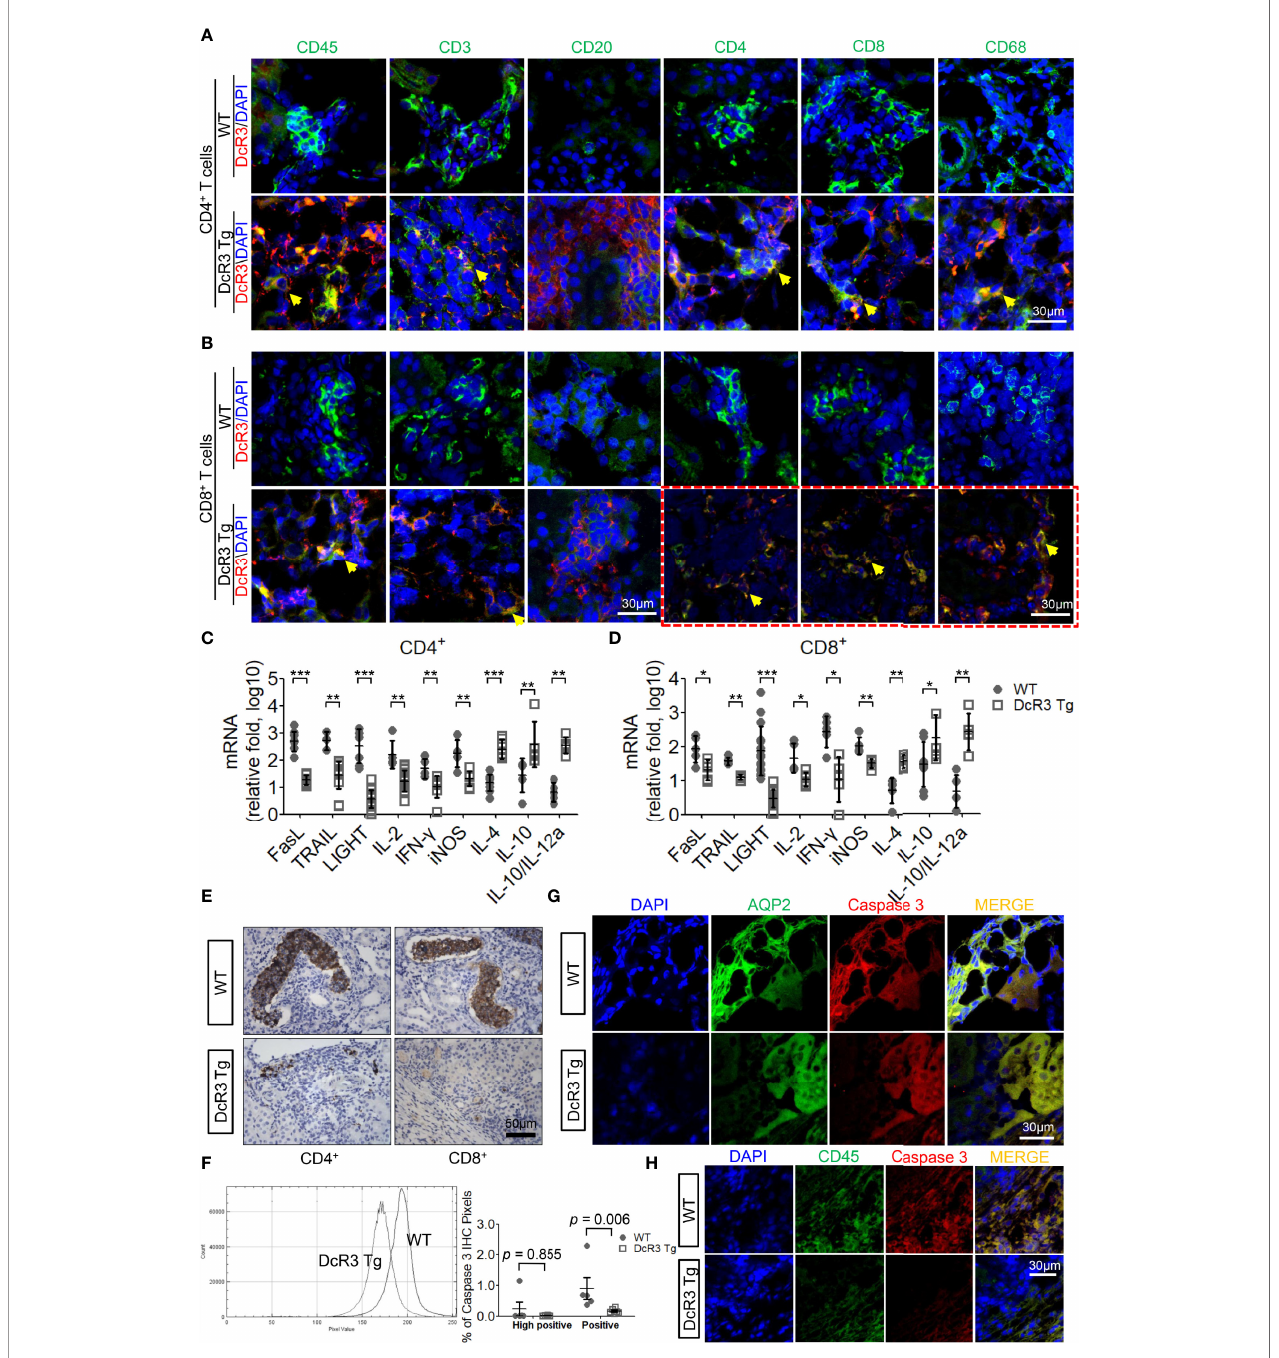
FIGURE 2 | The decoy receptor 3 (DcR3) interaction with T-cell markers correlated with the interference of corresponding ligands, inducing anti-in fl ammatory cytokines and death decoy function. (A, B) Merged immuno fl uorescence (IF) double staining for CD45, CD3, CD20, CD4, CD8, CD68, and DcR3 in acute cell rejection (ACR) wild-type (WT) and DcR3 transgenic (Tg) mice (×600). CD4, CD8, CD68, and DcR3 IF double staining after CD8 + T-cell injection (×1,200). (C, D) Real-time PCR analysis of mRNA levels of the indicated genes in the kidney tissue of ACR WT or DcR3 Tg mice at day 7 after activated CD4 + and CD8 + T-cell injection. Data are presented as fold change relative to the GAPDH mRNA level and are representative of at least fi ve independent experiments, followed by a Mann – Whitney U -test. Dot plots represent mean ± SD. (E) Cleaved caspase 3 immunohistochemical (IHC) staining of CD4 + - or CD8 + -related ACR WT and DcR3 Tg mice at day 7. (F) Quantitative data of cleaved caspase 3 IHC staining. The percentage of high positive and positive caspase 3 IHC staining of kidney tissue, respectively, were examined and averaged under 20 randomly selected high-power fi elds [×200; WT ( n = 5) and DcR3 Tg ( n = 6)]. (G, H) IF double staining was performed for cleaved caspase 3, aquaporin 2, and CD45 from WT and DcR3 Tg mice. * p < 0.05, ** p < 0.01, and *** p < 0.001 compared with